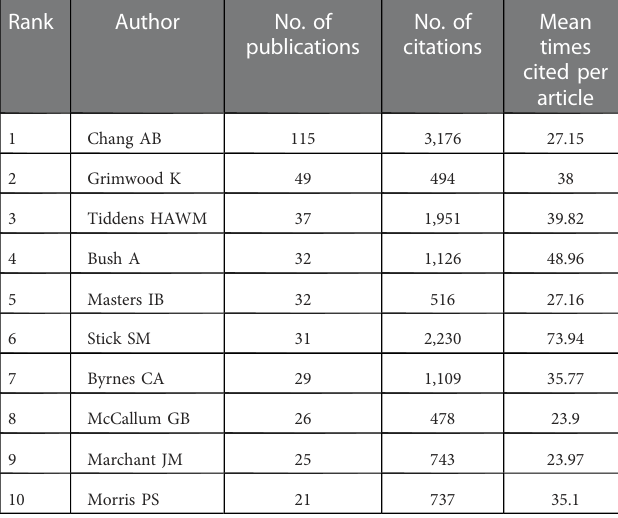
TABLE 3 Top 10 authors and co-cited authors of bronchiectasis in children between 2003 and 2022. Rank